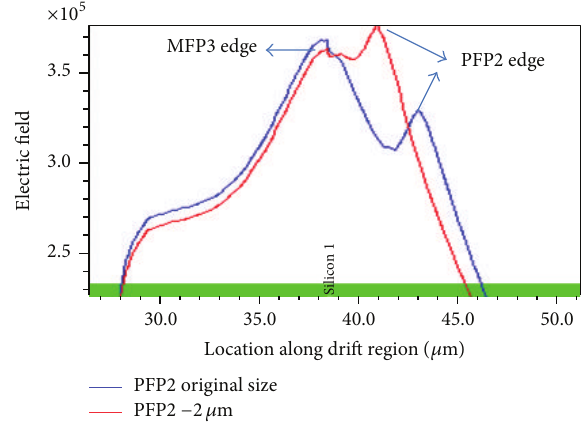
Figure 7: Lateral electric field distribution of MFP shrunk 5 𝜇 m for PFP2 no change and with 2 𝜇 m shrink.